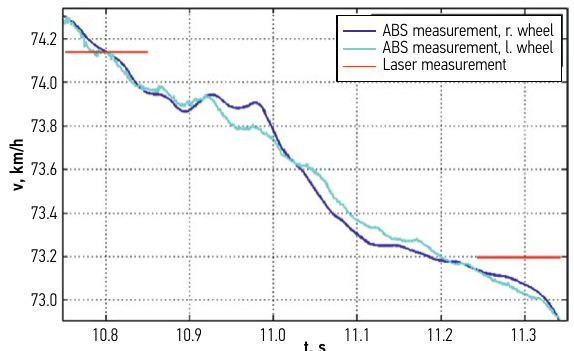
Fig. 8. Experimental ABS sensor data, car velocity